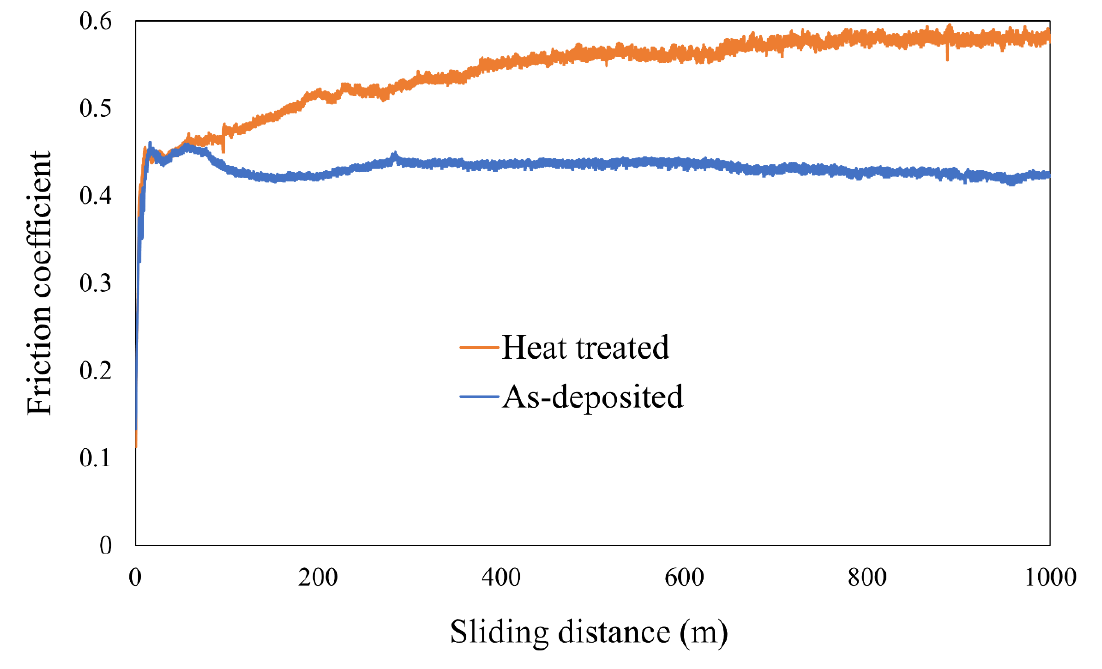
Figure 8. Evolution of friction coefficient of the as-deposited and heat-treated samples determined during a 1000 m of ball-on-disk sliding test.